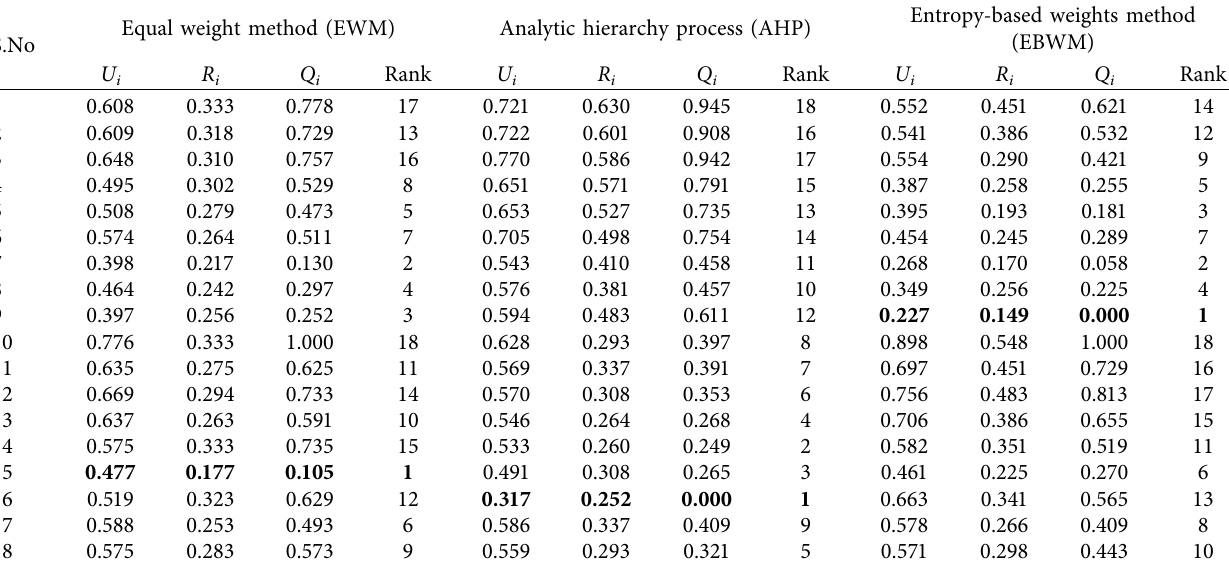
Table 5: VIKOR index and ranking for EWM, AHP, and